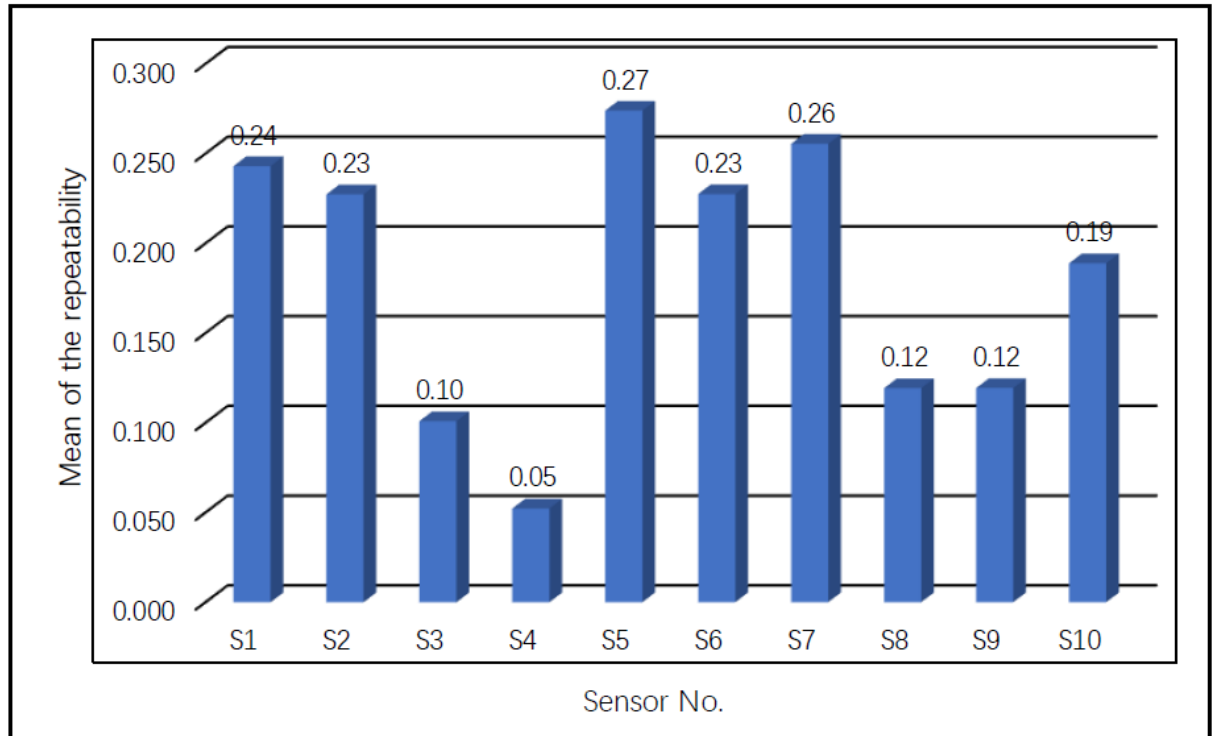
Figure 9. The average values of the sensors’ repeatability evaluation results.